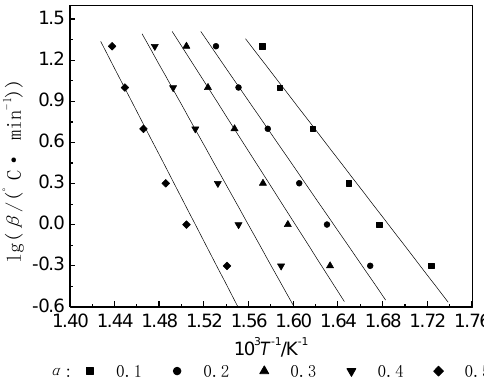
Figure 4. Isoconversional plots of BIIR decomposition in air. Table 4. Apparent activation energy ( E) and frequency factor ( A) at different fractional mass loss ( α ) values for BIIR decomposition in air.